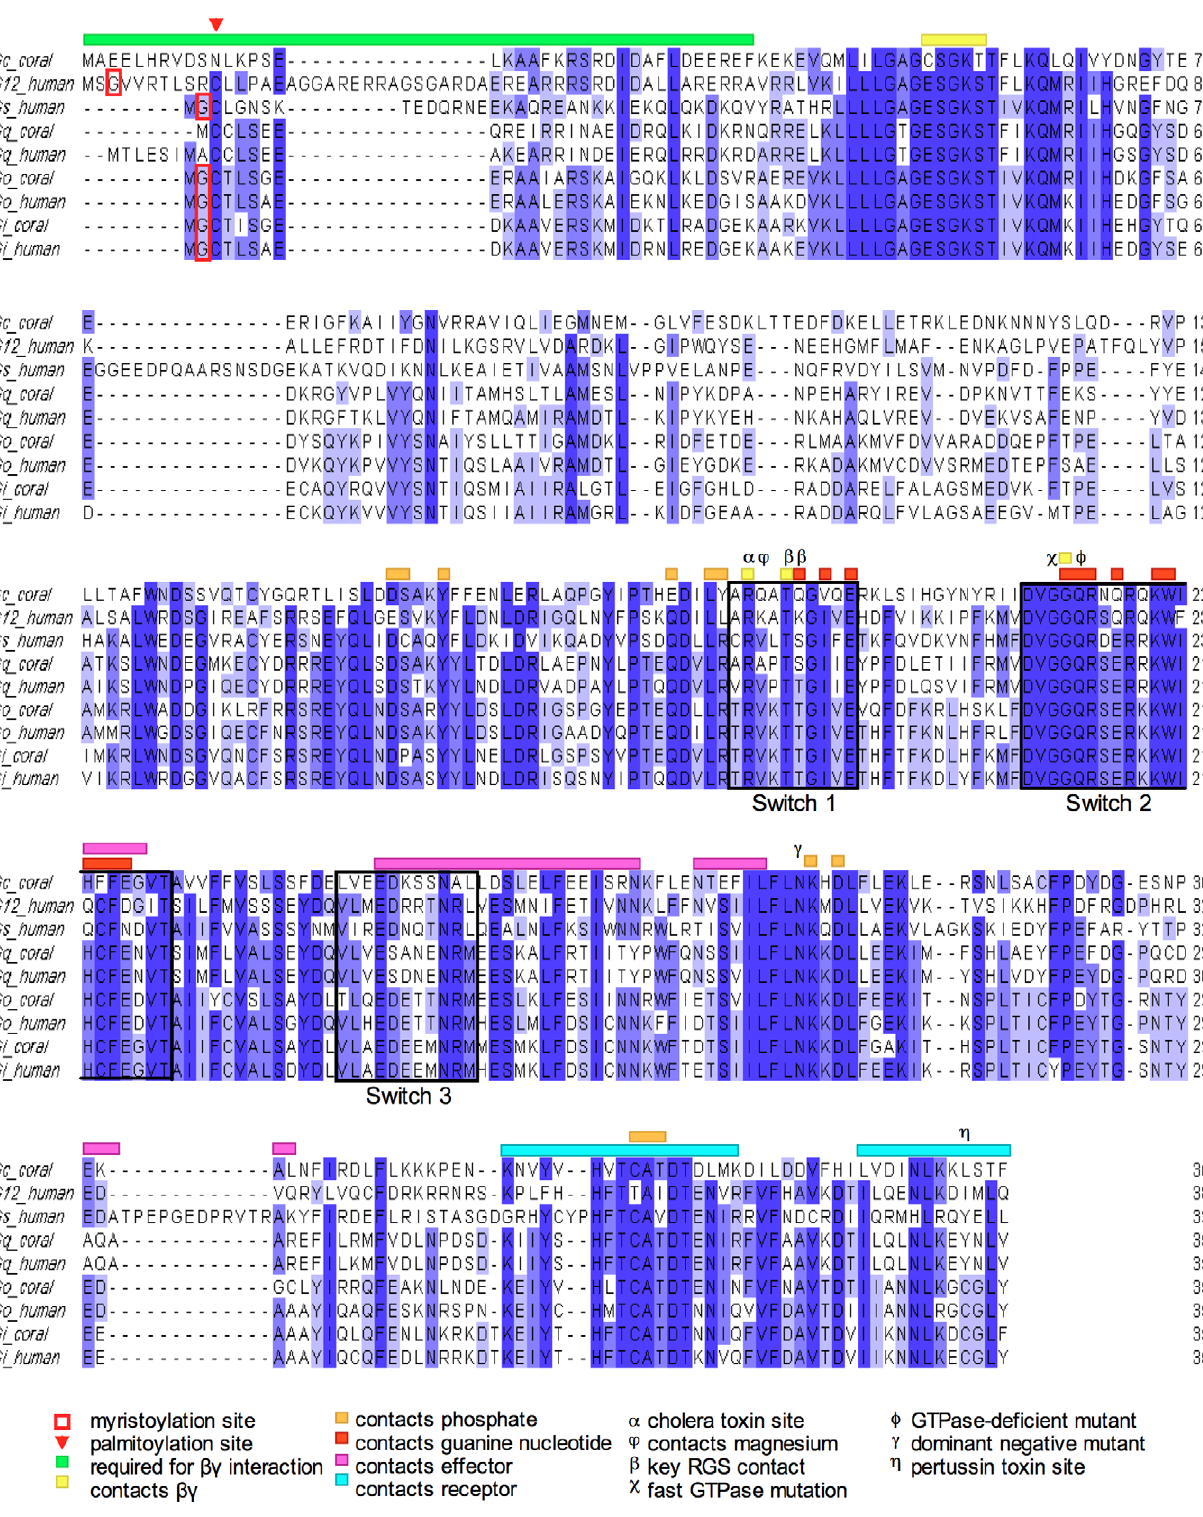
Figure 4. Annotated alignment of coral and human G protein alpha subunits. Alignment of four coral G protein alpha subunits (Gc_coral (JQ966103),Gi_coral (JQ966104), Go_coral (JQ966105), and Gq_coral (JQ966106)) with representatives of the human G alpha subunit families - human Gi, Go, Gq, Gs, and G12. (Gi_human (P04899.3), Go_human (P09471.4), GNAQ_human (P50148.4), GNA12_human (Q03113.4)). The alignment was constructed using MUSCLE (48) and decorated in Jalview (49). Shading indicates identity. Switch regions are indicated by black boxes. Other functional residues and domains (50,51) are indicated, as described in the key.